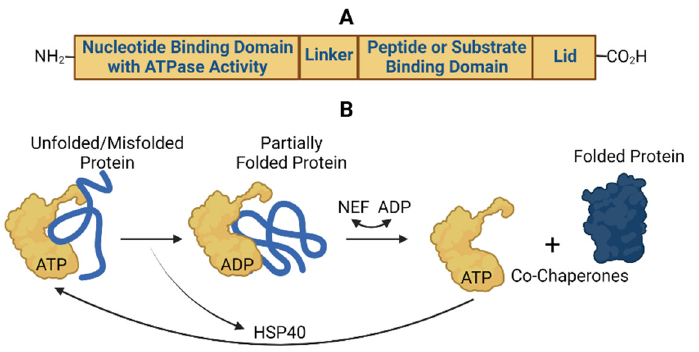
Figure 2. Common structural elements ( A ) and protein folding functions ( B ) of Hsp70, hsc70, Grp78 and mortalin.